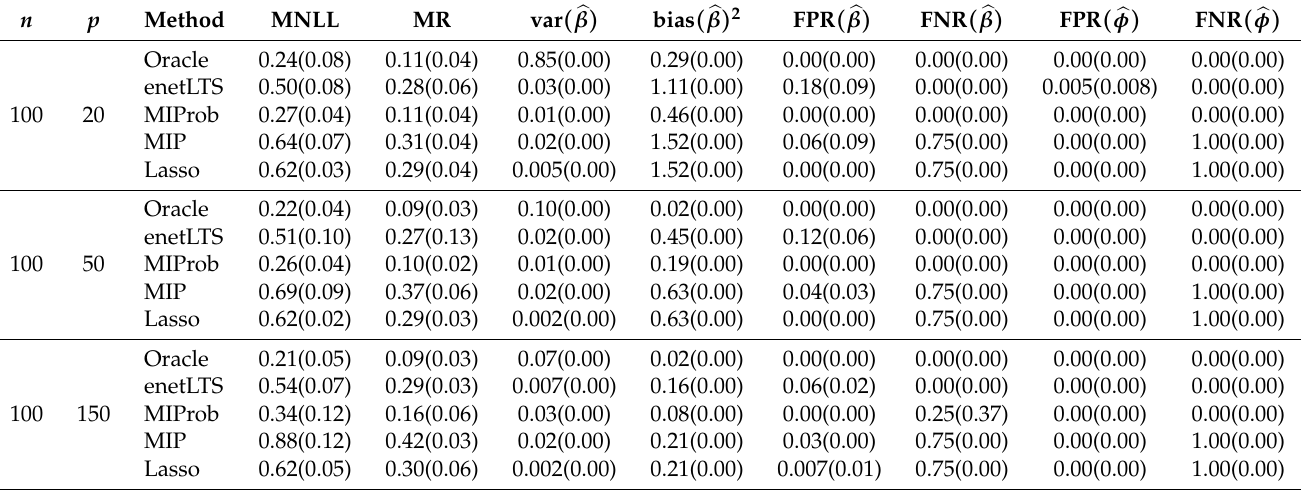
Table 1. Median (MAD in parenthesis) of MNLL, misclassification rate, variance and squared bias for (cid:98) β , false positive rate and false negative rate for feature selection and outlier detection based on 30 simulation replicates.